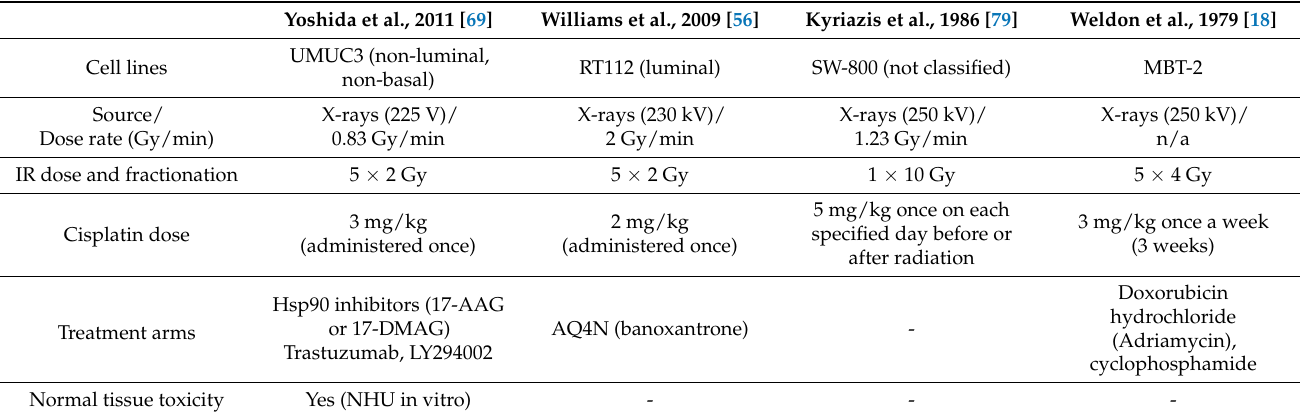
Table 5. Overview of preclinical studies using Cisplatin in BCa in vivo in combination with RT. Yoshida et al., 2011